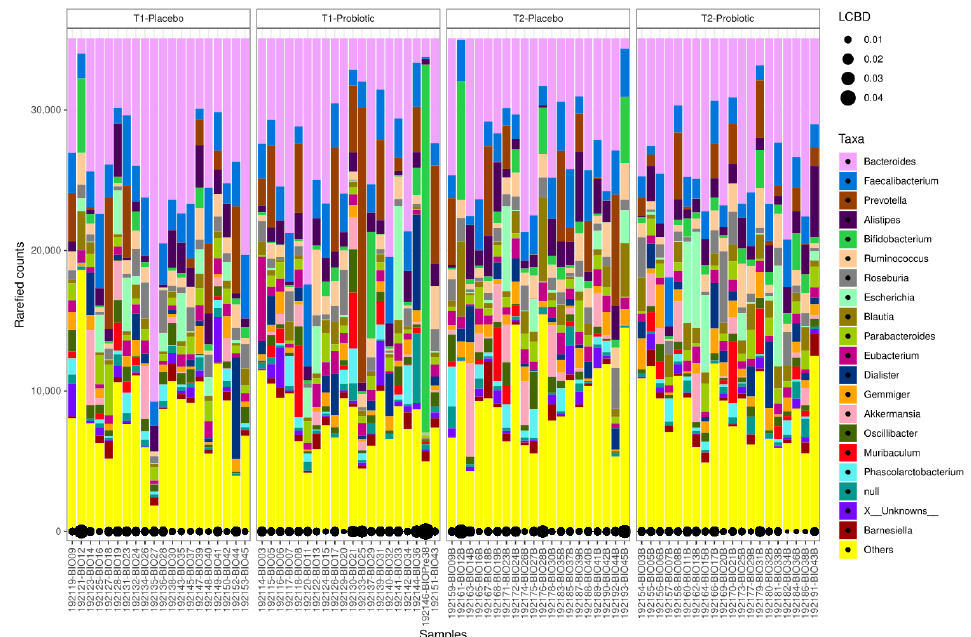
Figure 2. Local contributions to beta diversity (LCBD) analysis at family level ( right ) and genus level ( left ) from taxonomic identification of the samples sequenced (42 samples in the placebo group and 44 samples in the probiotic group; T1: before test #1, T2: at 6 weeks before test #2).